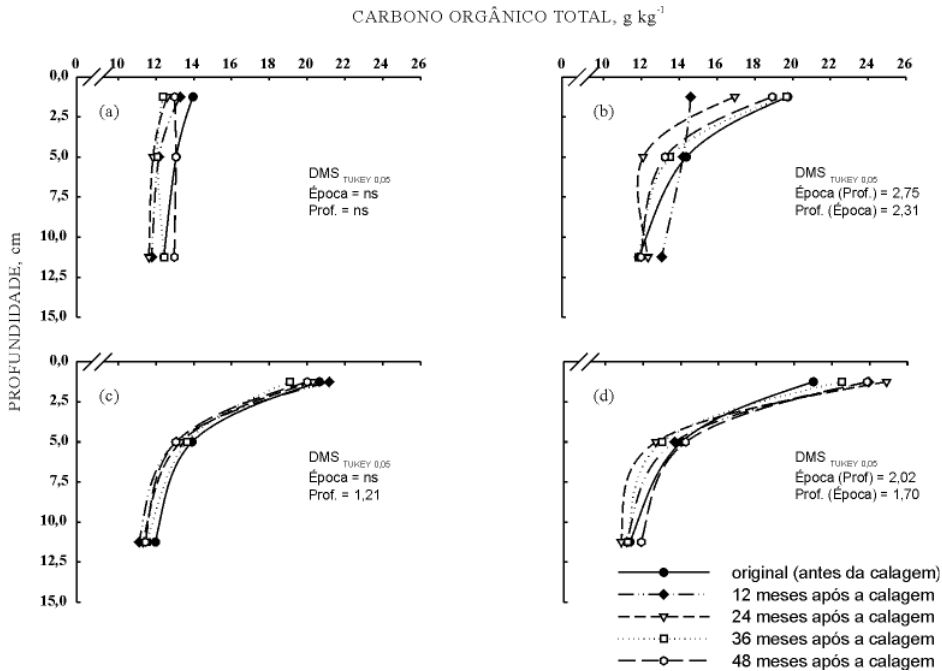
Figura 6. Carbono orgânico total do solo em diferentes épocas de avaliação, profundidades e sistemas de manejo: (a) convencional durante 12 anos; (b) semeadura direta com revolvimento do solo a cada quatro anos; (c) semeadura direta durante oito anos; (d) semeadura direta durante 12